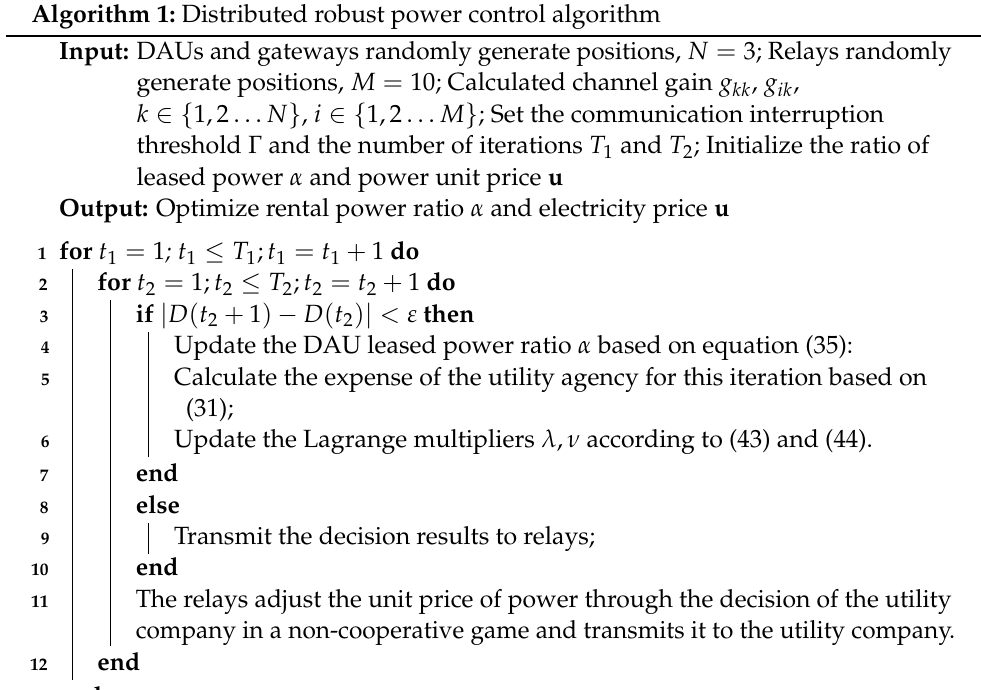
Algorithm 1: Distributed robust power control